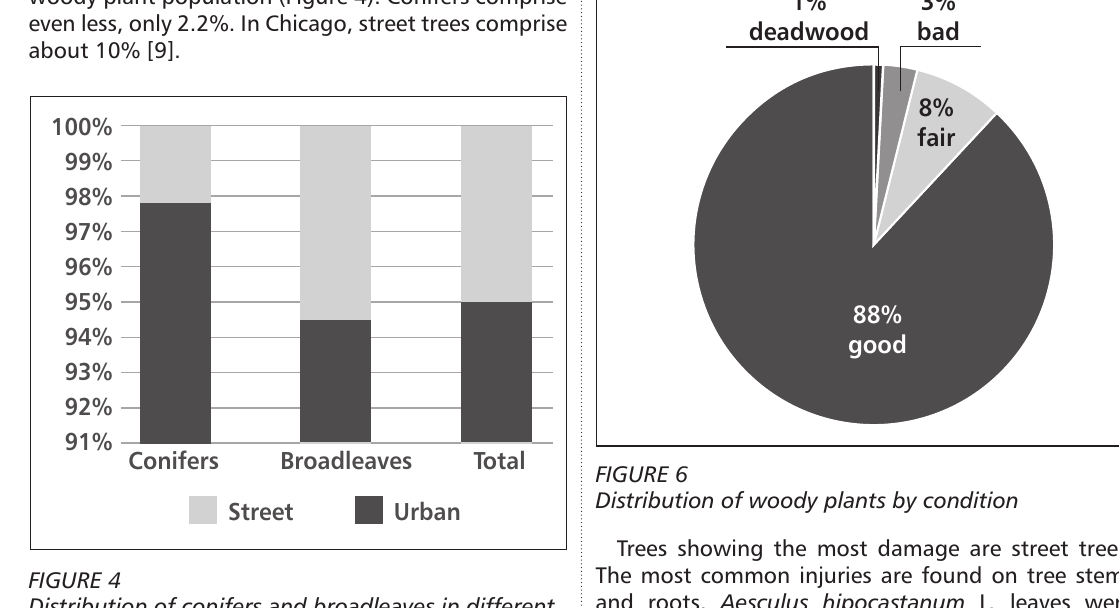
Distribution of conifers and broadleaves in different green spaces